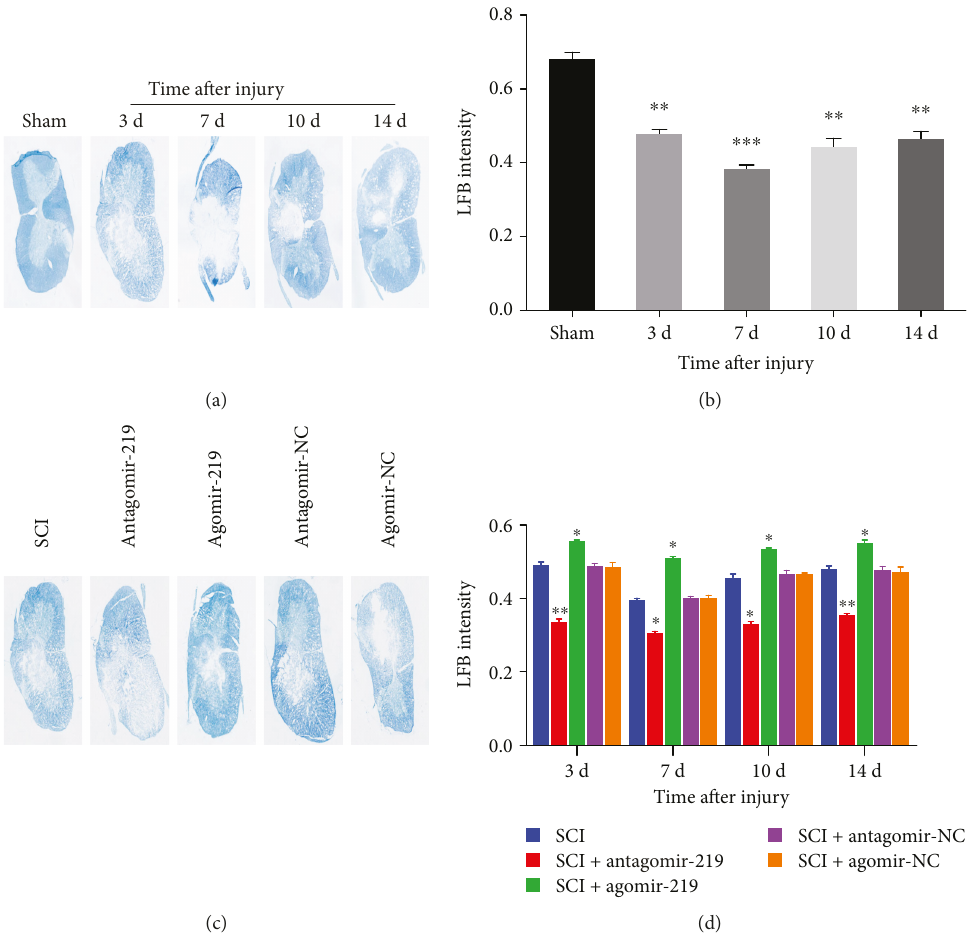
Figure 4: Typical images of Luxol fast blue (LFB) staining for assessment of myelination following contusion SCI. (a) LFB staining for evaluation of myelination indicated demyelination after contusion SCI. (c) The results of LFB staining revealed partial restoration of myelination in animals treated with agomir-219 and aggravated demyelination in the antagomir-219 group (representative images at 3 days after SCI). In addition, no signi fi cant group di ff erences were observed between the antagomir-NC or agomir-NC and SCI groups. (b, d) Quanti fi cation results of LFB staining. ∗ p < 0 05 , ∗∗ p < 0 01 , and ∗∗∗ p < 0 001 . NC: negative